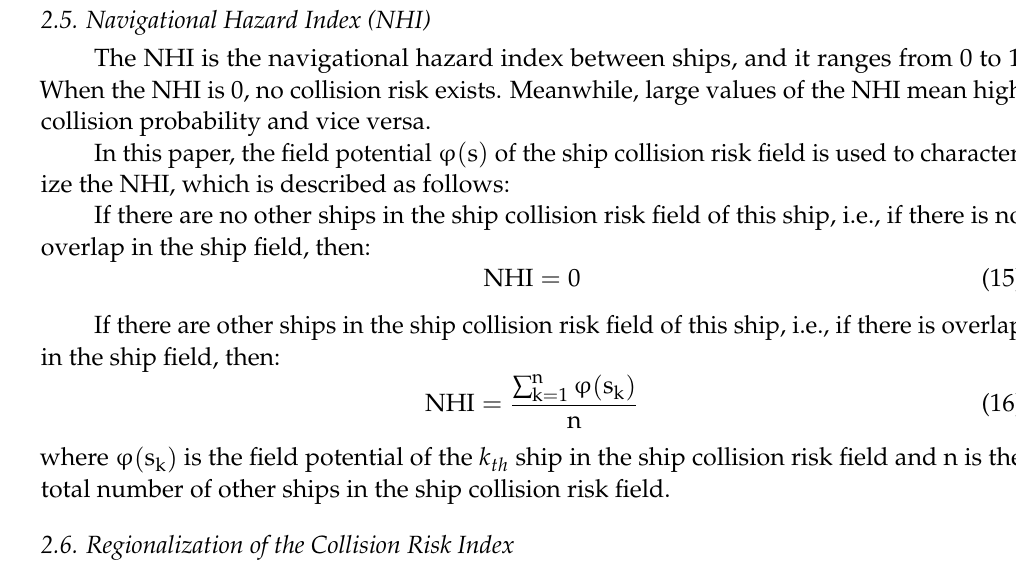
Figure 3. Schematic diagram of single-ship collision risk field: ( a ) three-dimensional view of single- ship collision risk field; ( b ) top view of single-ship collision risk field.